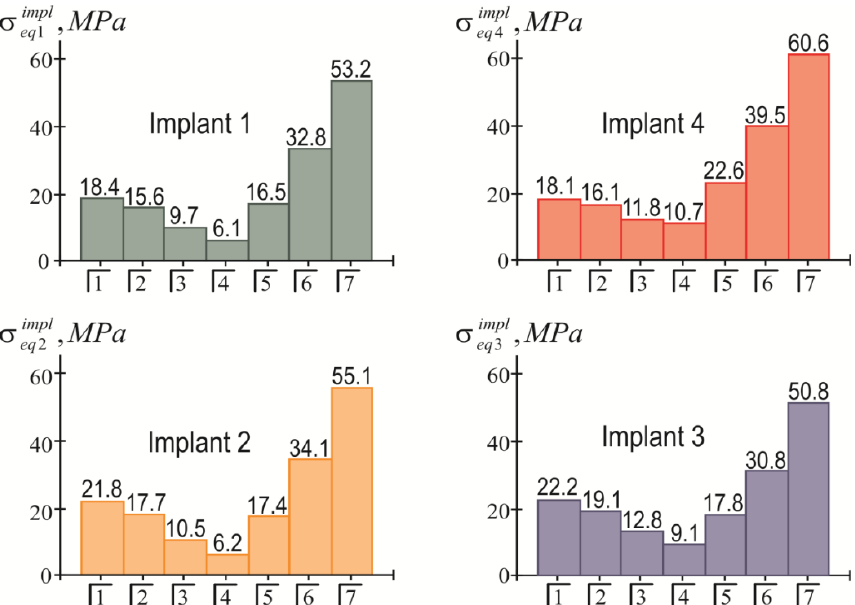
Figure 8. Dependence of the maximum equivalent stresses in implants on the location of the mas- tication load (the first variant of implant placement).